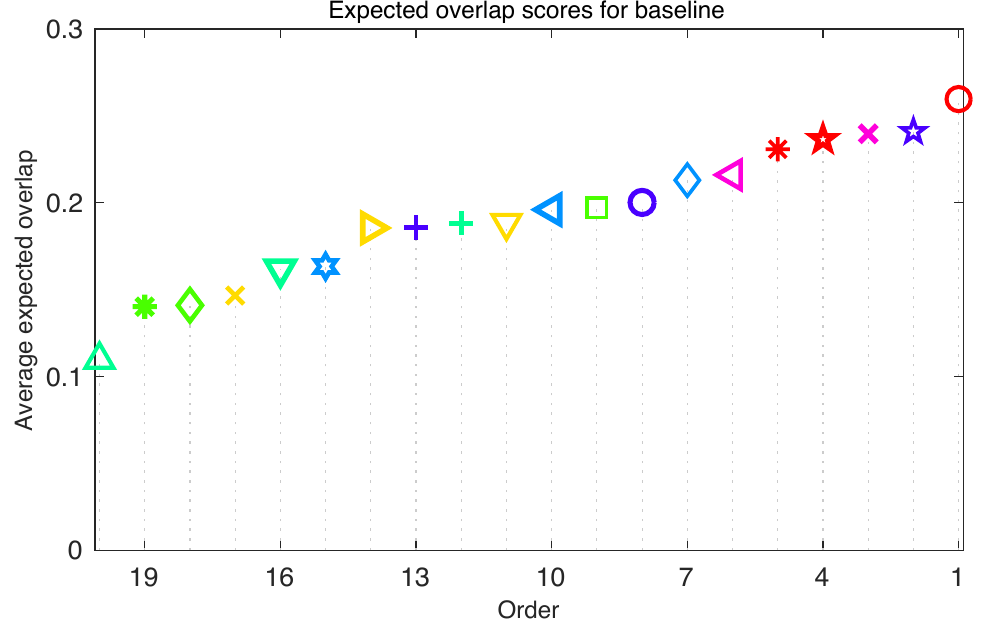
Figure 8. Expected overlap scores of 20 compared trackers on VOT-TIR2016 (see Figure 6 for legend).